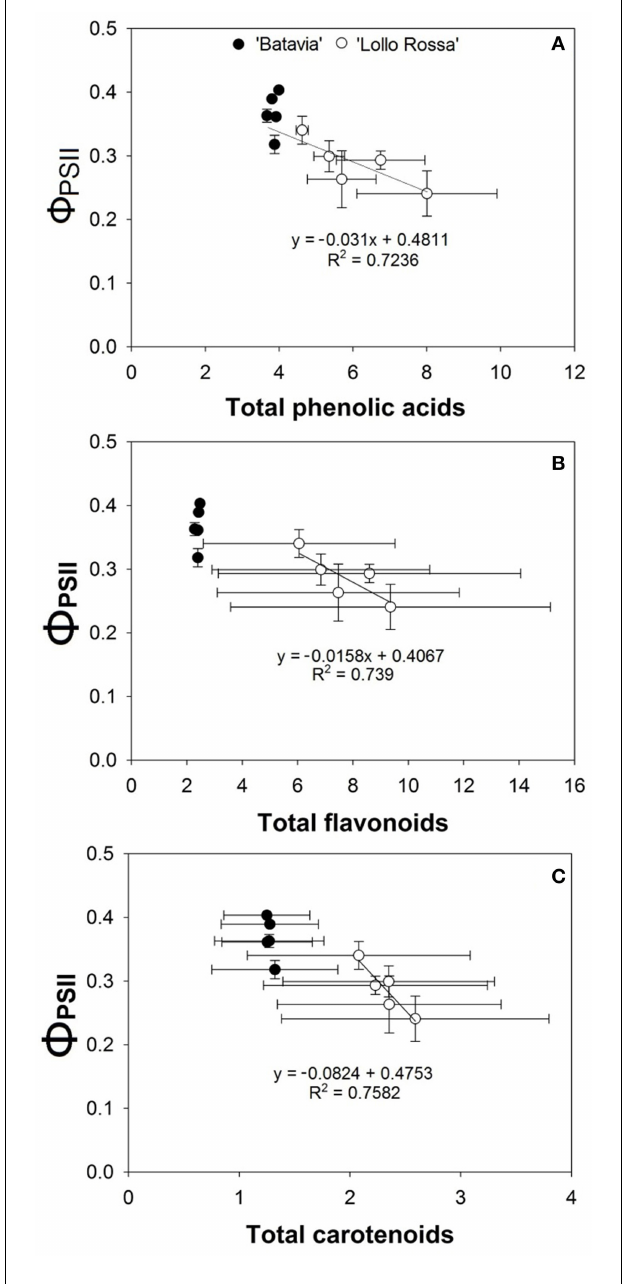
FIGURE 10 | Correlation between the quantum efficiency of PSII ( (cid:2) PSII ) at 1100 μ mol m − 2 s − 1 and the amount of (A) phenolic acids, (B) flavonoids, and (C) carotenoids of Lactuca sativa “Batavia”( • ) and “Lollo Rossa” ( ◦ ) grown under the five different LED treatments with the same abbreviations as in Figure 2. Data are mean values ( n = 3, three different leaves from different plants per treatment and cultivar) ± SE. could also be cultivar or species dependent (Loreto et al.,